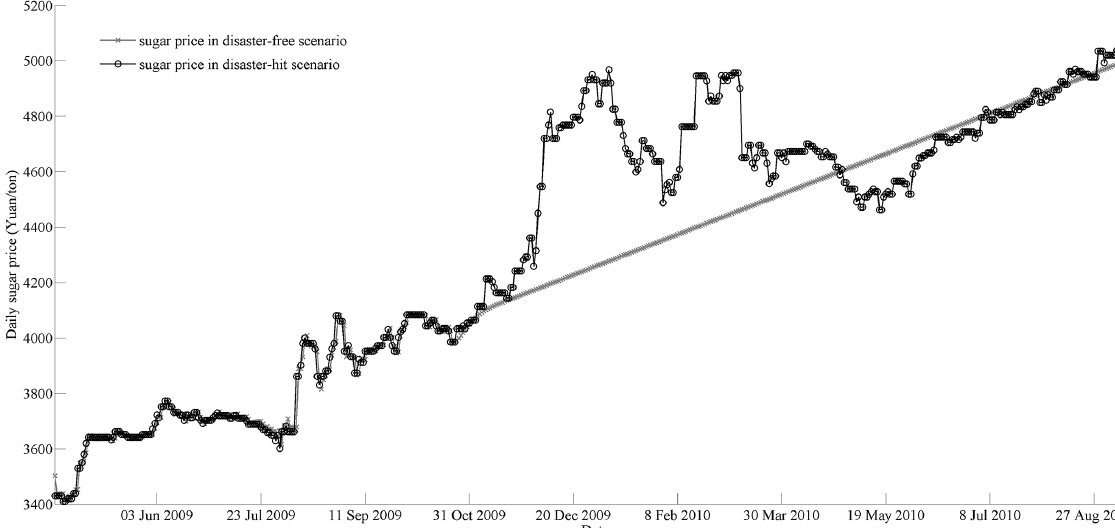
Figure 3. Sugar price in disaster-free and disaster-hit conditions in the 2009/2010 season.